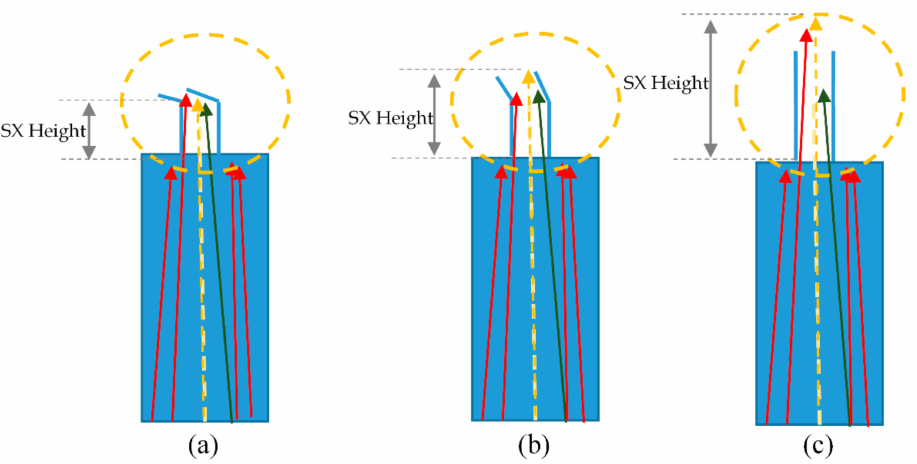
Figure 5. Grain growth direction in selector part with di ff erent take-o ff angles. ( a ) θ < 45 ◦ ; ( b ) θ = 45 ◦ ; ( c ) θ > 45 ◦ .